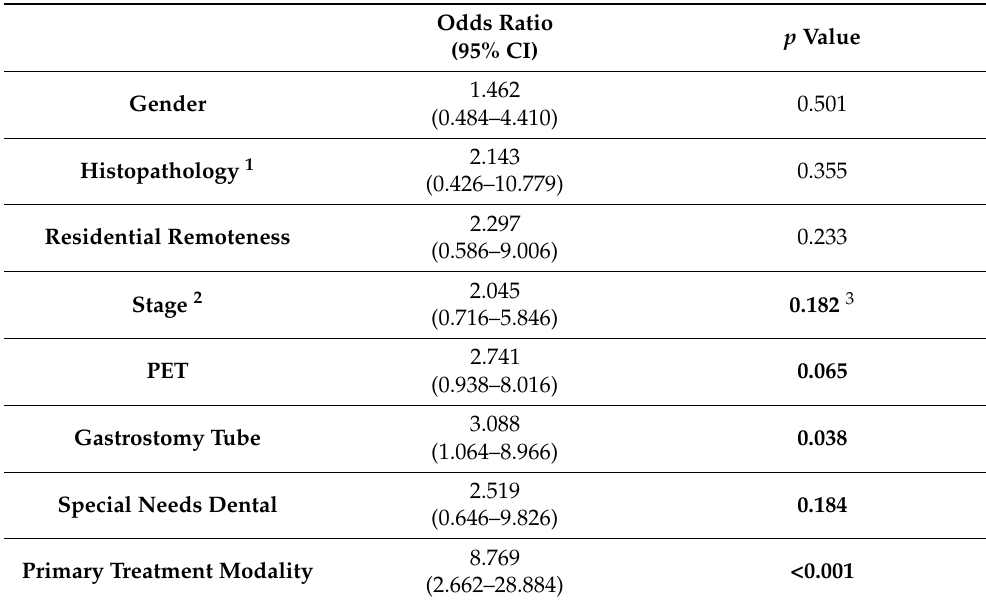
Table 4. Univariate logistic regression findings for evaluating factors predictive of not meeting the 56 day guideline from time of referral to treatment